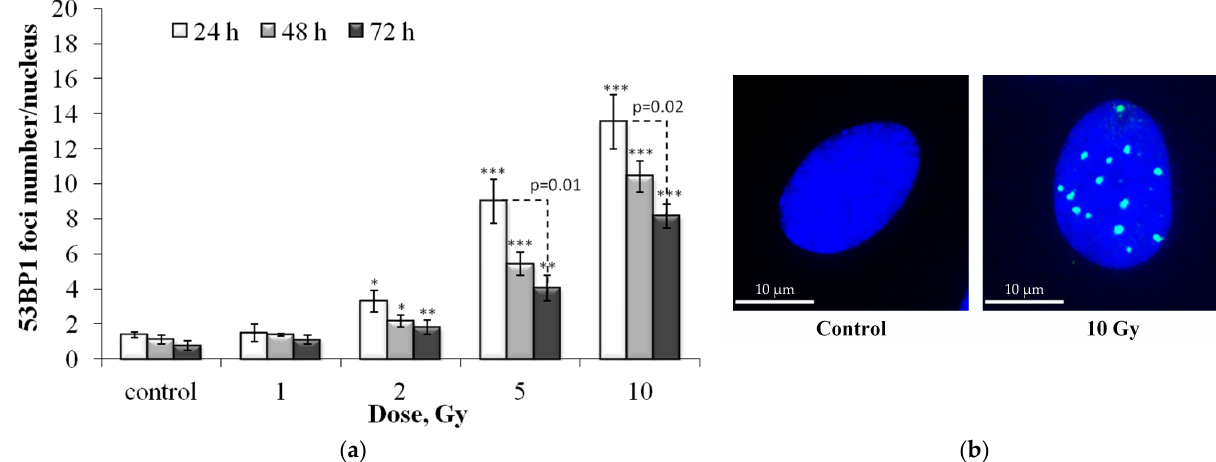
Figure 3. ( a ) Dose-dependent changes in the number of residual 53BP1 foci in human fibroblasts 24 h, 48 h and 72 h after irradiation. Data are means ± SE of three independent experiments. * p < 0.05, ** p < 0.01 and *** p < 0.001—compared with the corresponding time of control; ( b ) Representative microphotographs of immunocytochemically stained control and 10 Gy irradiated cells (24 h) showing nucleus (blue) and foci (green).